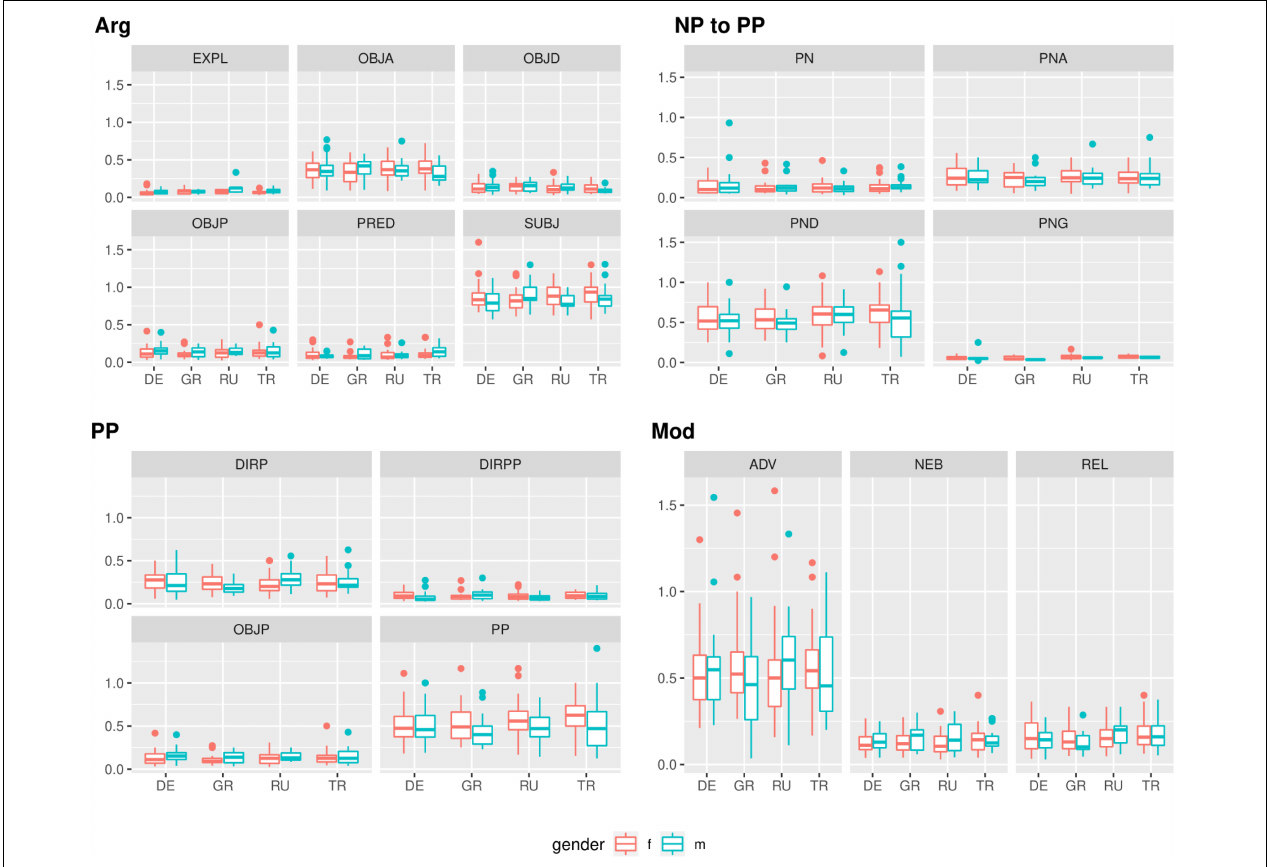
FIGURE 3 | Dependencies in maj-German (formal-written) RUEG texts, normalized by lexical